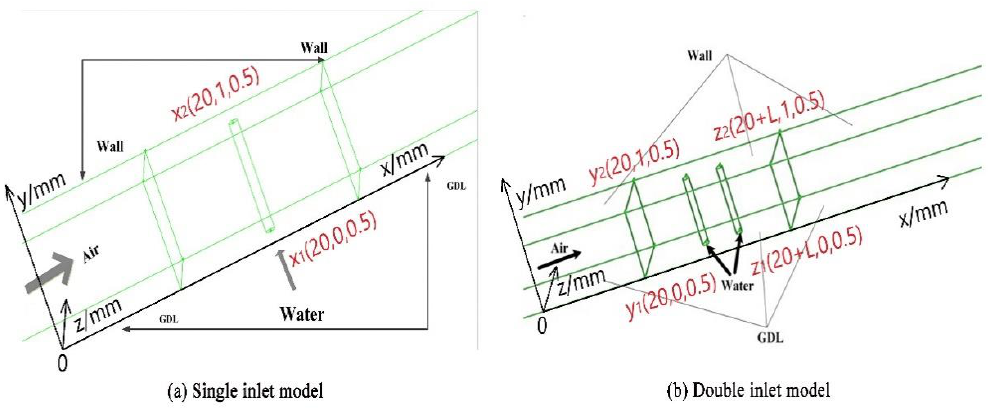
Figure 1. Simplified channel model. (( a ) Single inlet model, ( b ) Double inlet model).